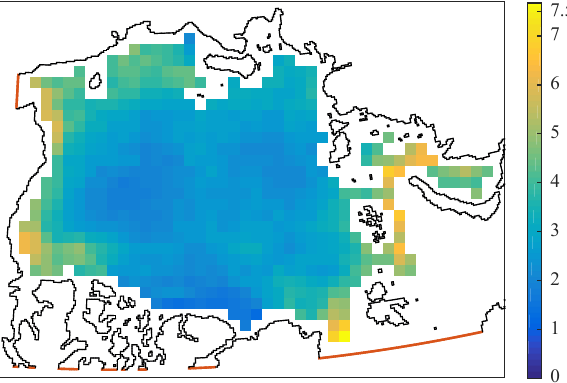
Figure 1. Systematic errors in the neXtSIM ice velocities com- pared to observations from the OSI-SAF dataset. Simulated and ob- served ice drift is averaged over the period from 1 January 2008 to 30 April 2008. The cells with less than 28 observations over the winter are masked. The colour scale represents the velocity in kmday − 1